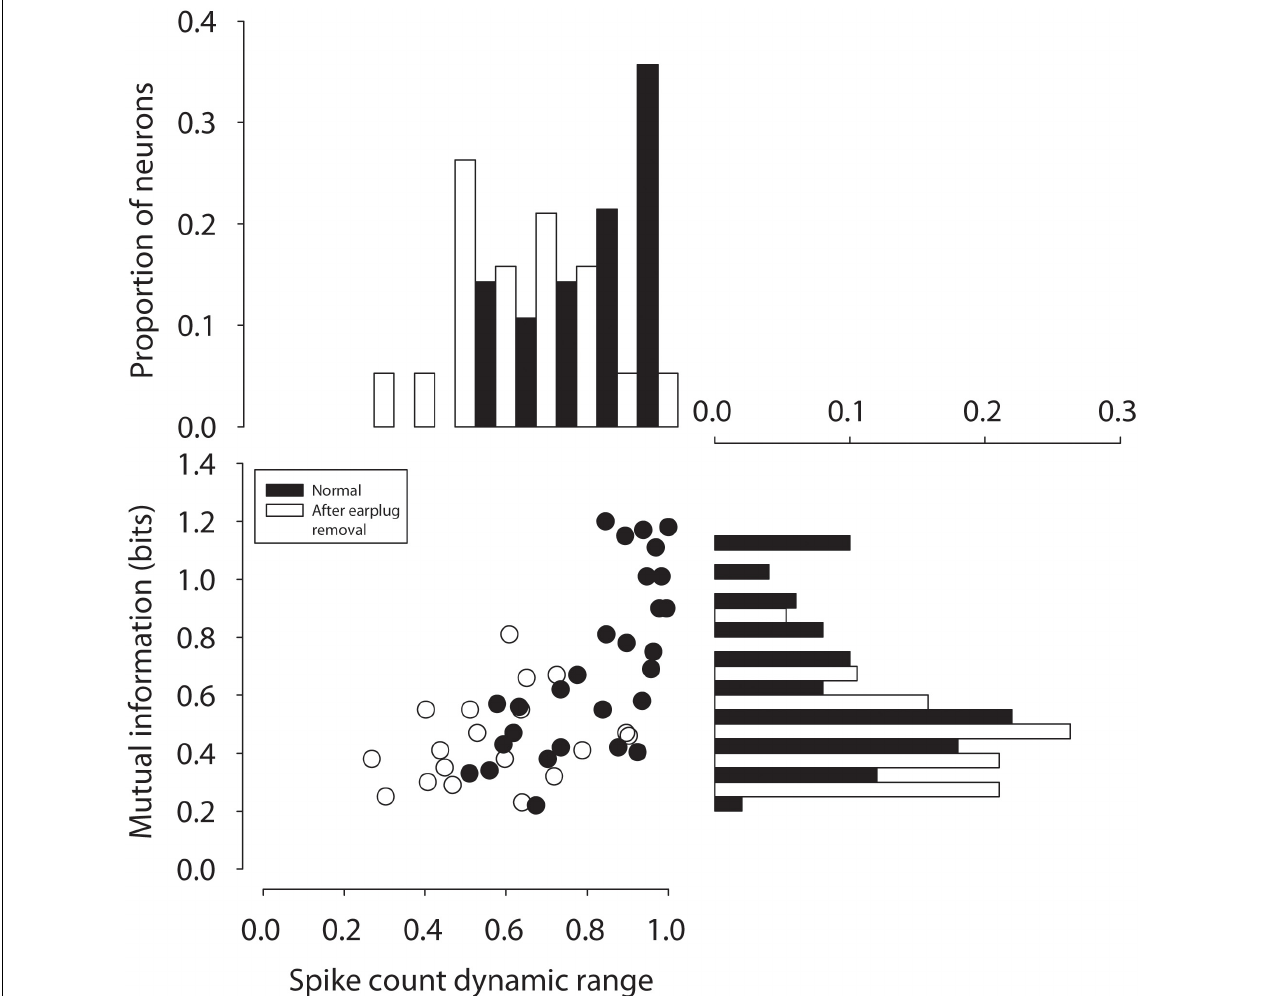
FIGURE 4 | Mutual information between spike count and ILD in ICC neurons in normal-hearing (black circles) adults and after 6 weeks of unilateral CHL (open circles) is plotted as a function of the spike count modulation dynamic range by ILD (% re: max